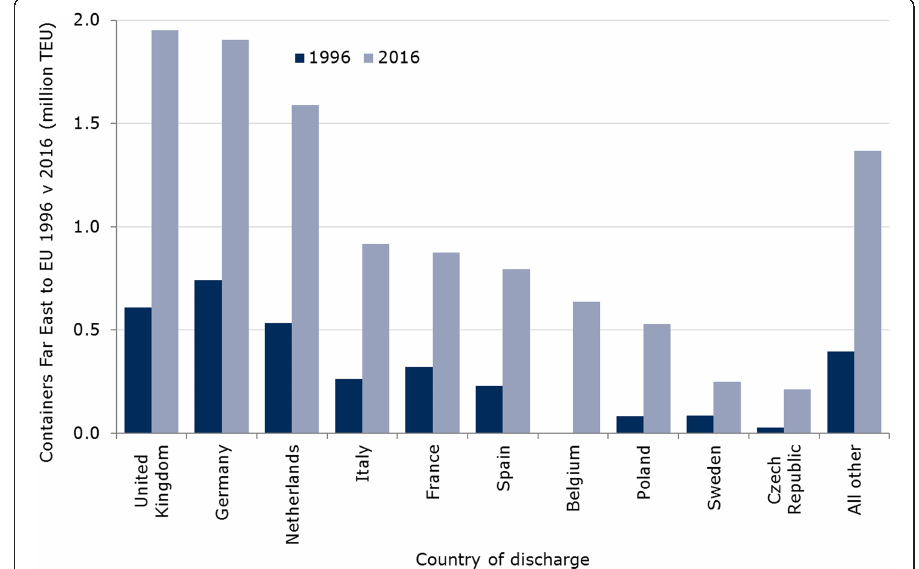
Fig. 3 Loaded containers from the Far East to Europe: country of discharge (from